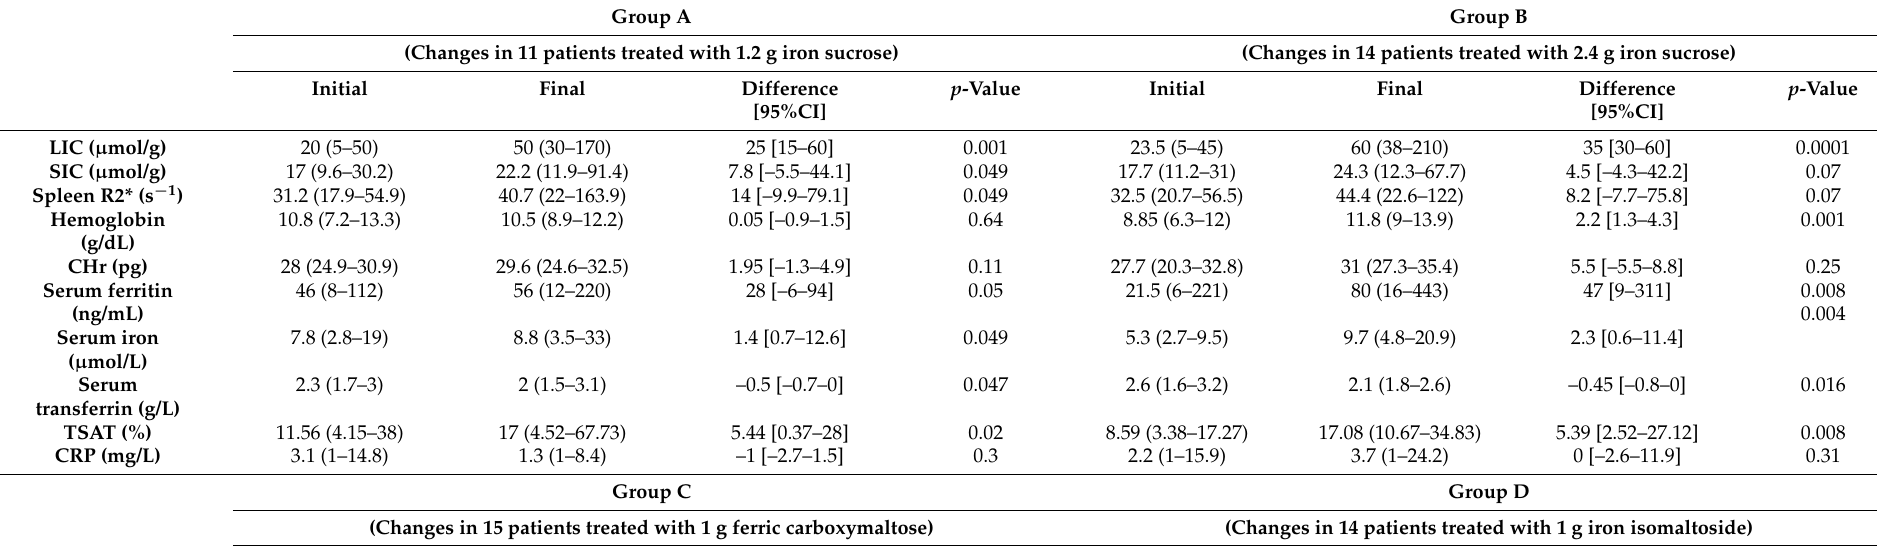
Table 2. Biological variables in the four treatment groups before and after IV iron